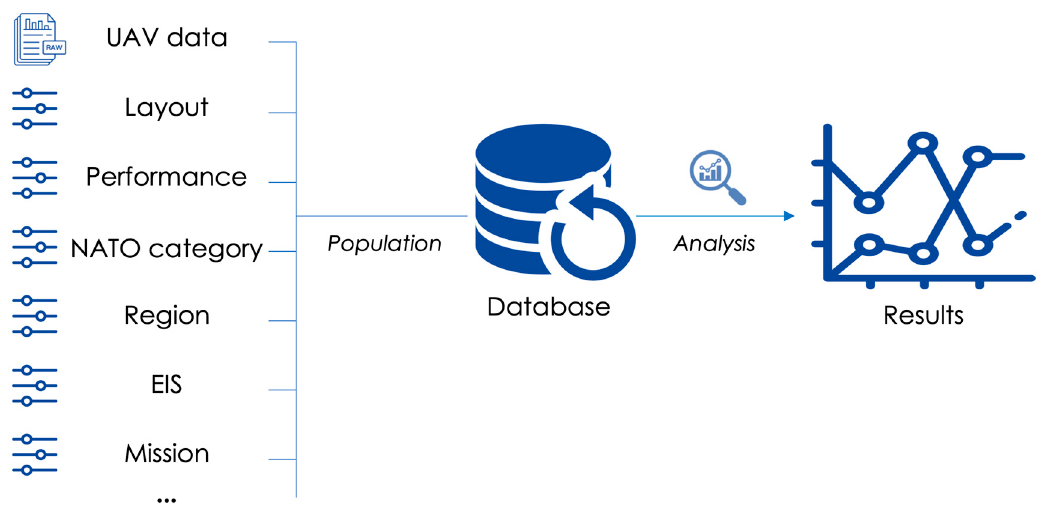
Figure 1. Methodology fl owchart.